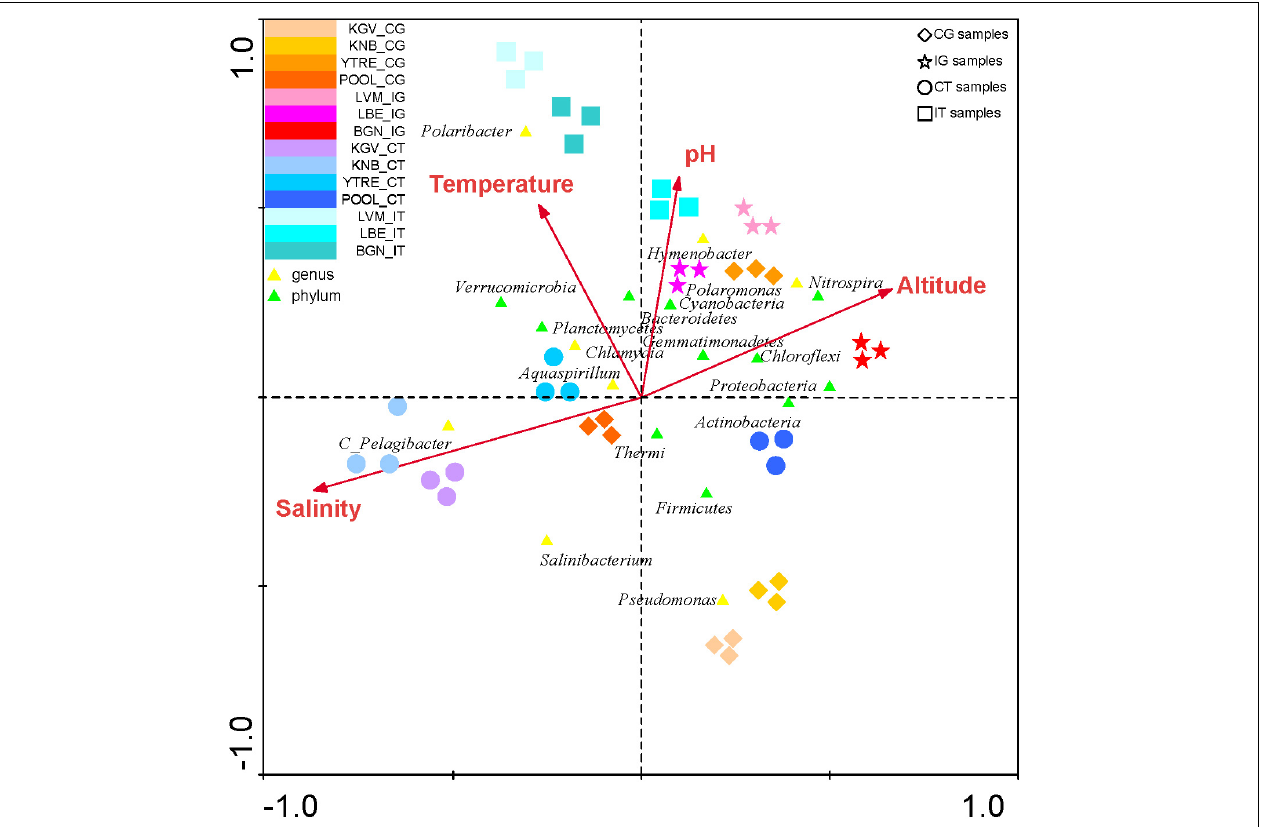
FIGURE 6 | Canonical Correspondence Analysis of the microbial phyla and of the main genus in each sampling site with respect to environmental variables. The analysis of the bacterial communities with respect to both environmental variables (temperature, pH, salinity and altitude) was represented. The diagram displays triangles that represent taxonomic groups. Sampling sites are represented by different shapes ( : CG samples, ∗ : IG samples, ◦ : CT samples and (cid:3) : IT samples). Arrows symbolize environmental variables. The axes are scaled in standard deviation (cid:51)